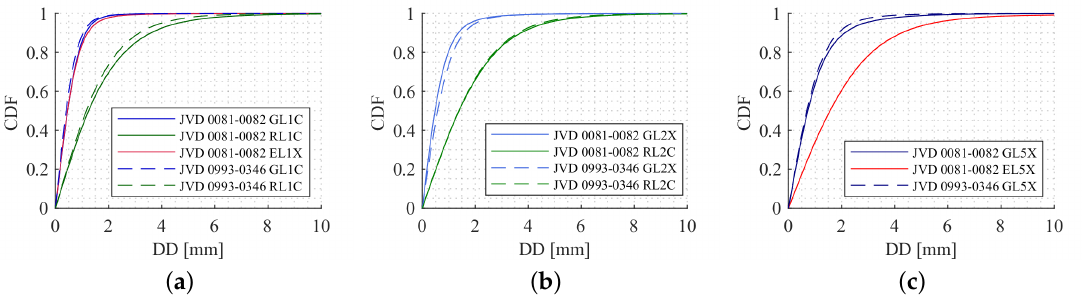
Figure 17. DDs CDFs for L1 ( a ), L2 ( b ) and L5 ( c ) carrier phase observations from all the satellites of different systems with two different receiver